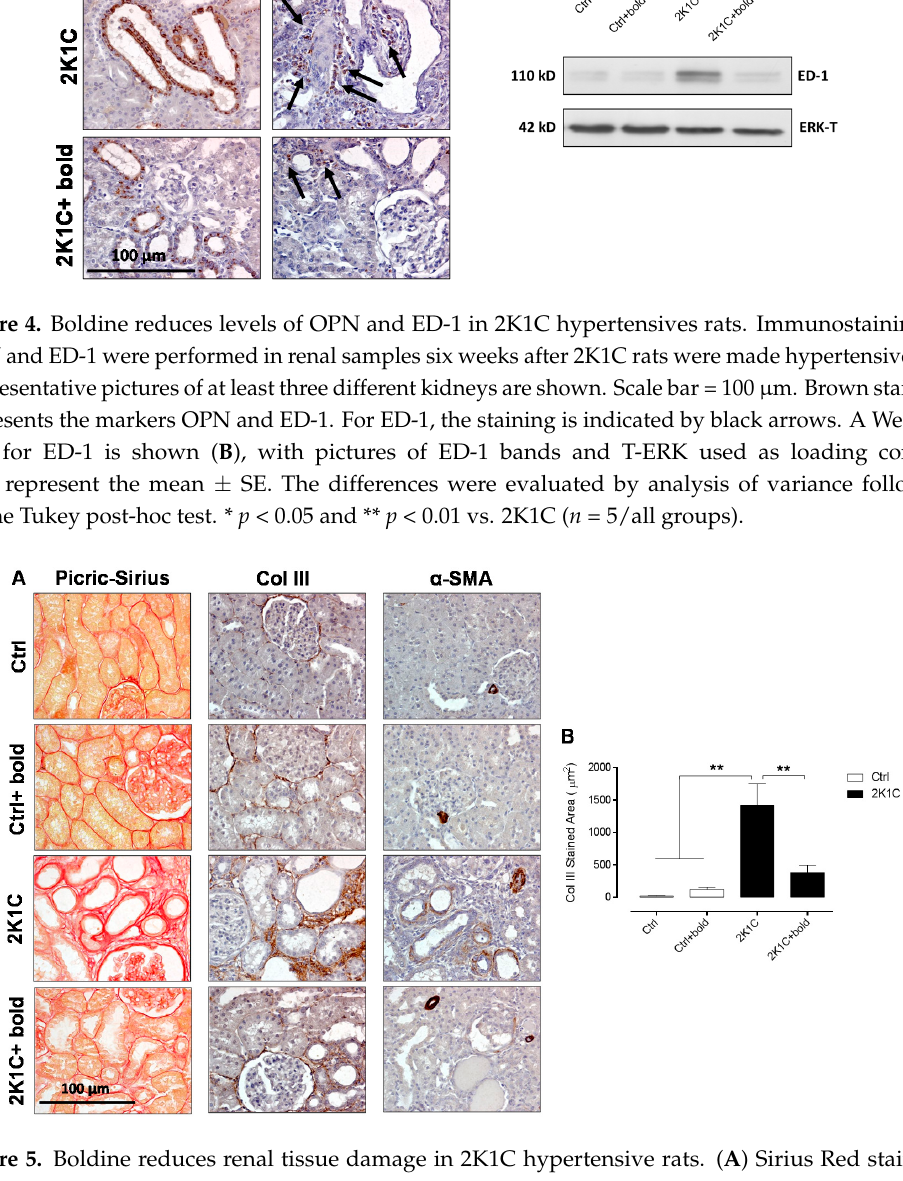
Figure 4. Boldine reduces renal tissue damage in 2K1C hypertensive rats. ( A ) Sirius Red staining, α -SMA, and Col III immunostaining were performed in renal samples six weeks after 2K1C rats were made with hypertension; ( B ) Morphometric analysis of Col III staining in interstitial renal tissue. Representative pictures of at least three different kidneys are shown. Scale bar = 100 μ m. Red staining depicts collagen, while brown staining depicts α -SMA or Col III. The differences were evaluated by analysis of variance followed by the Tukey post-hoc test. ** p < 0.01 vs. 2K1C ( n = 5/all groups).